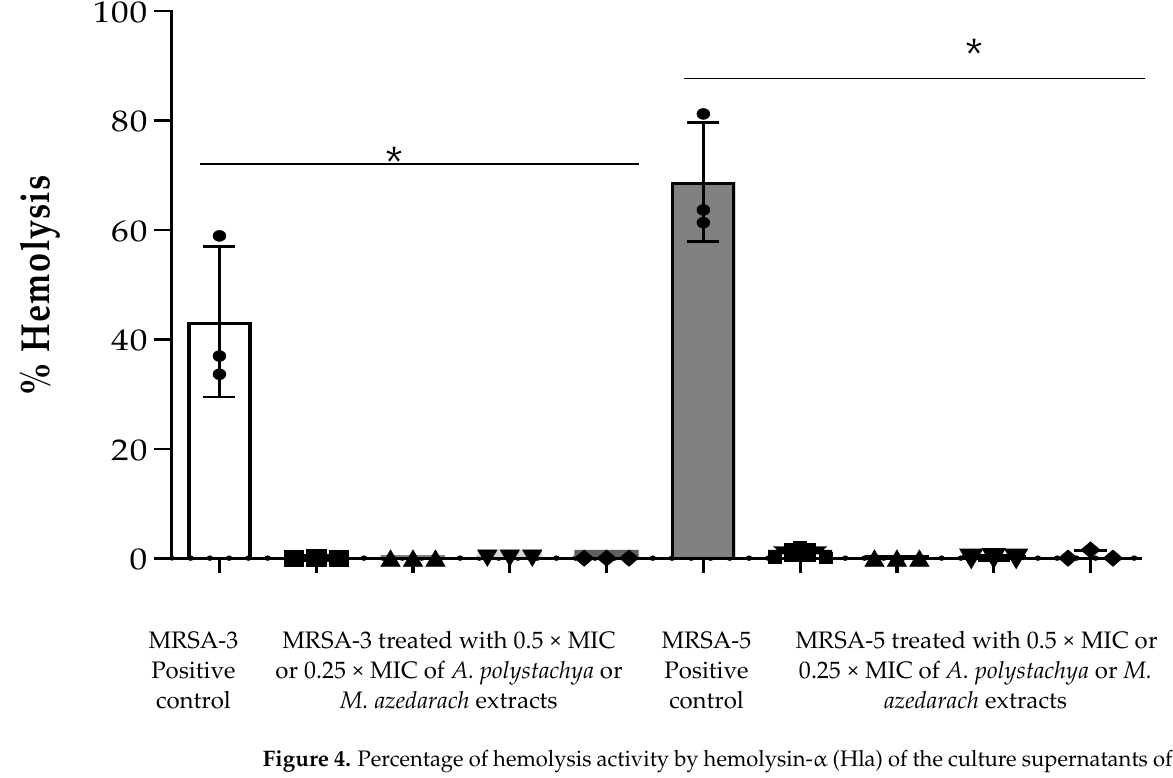
Figure 4. Percentage of hemolysis activity by hemolysin- α (Hla) of the culture supernatants of MRSA-3 or MRSA-5 treated or untreated with either Aphanamixis polystachya or Melia azedarach extracts. The symbols (cid:4) and (cid:78) represent the cells treated with 0.5 × MIC and 0.25 × MIC of Aphanamixis polystachya extract, respectively; (cid:72) and (cid:7) represent the cells treated with 0.5 × MIC and 0.25 × MIC of Melia azedarach extract, respectively. (*) Indicates presence of a statistically significant difference between columns (one-way ANOVA, followed by Tukey’s multiple comparisons, p -value < 0.0001). Data represent the means ± SD, n = 3.